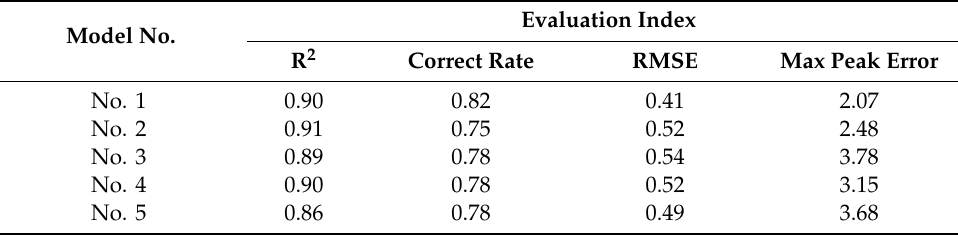
Table 11. Evaluation index value extracting only the data of each model where CRAC2 stopped. Model